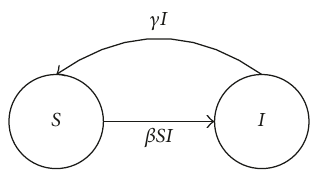
Figure 4: The chart model of